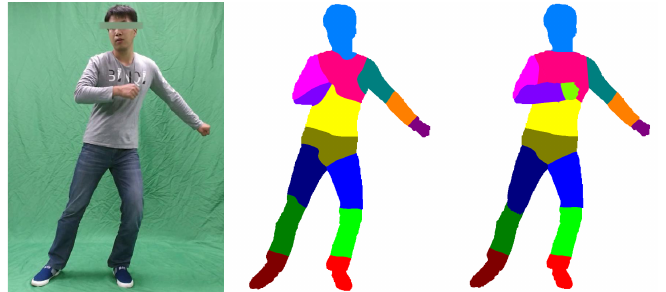
Figure 5. Body part kinematic classification. The left image is the source image recorded by an RGB camera, while the middle image is the classification result without the motion term. The classification result shown in the right-hand image is more precise than the result in the middle image, because of the motion